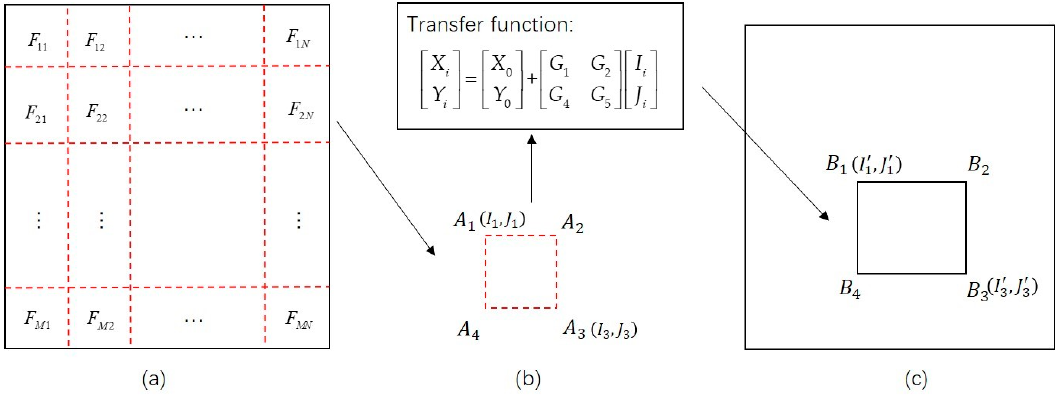
Figure 3. Schematic of the image partitioning strategy based on a geographical information constraint: ( a ) an input image and the image partition of the input image; ( b ) an image patch F 2N (with corners A 1 , A 2 , A 3 , and A 4 ) of the input image; ( c ) the corresponding reference image patch (with corners B 1 , B 2 , B 3 , and B 4 ) in a pre-earthquake image covering the input image patch.